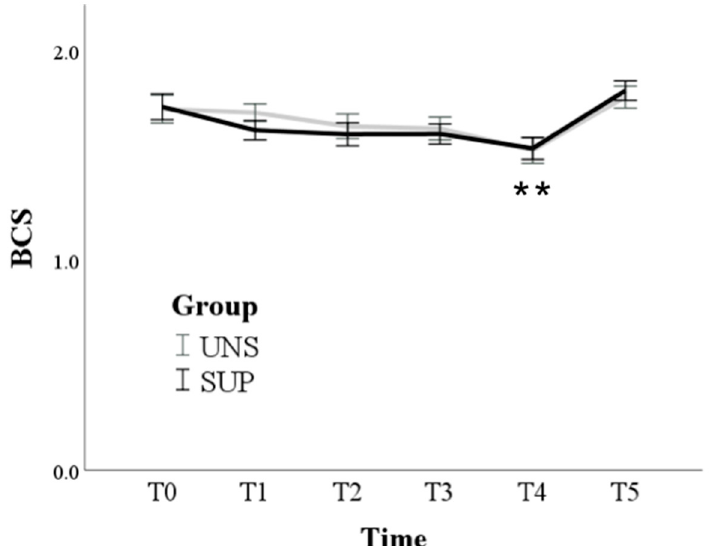
Figure 1. Means and standard errors of body condition score (BCS) in control (UNS) and supple- mented (SUP) lactating sheep monitored before the administration of supplementation (T0), and then every 10 days until dry off (T1–T5). ** p < 0.01 T4 vs. T0 in SUP and UNS.